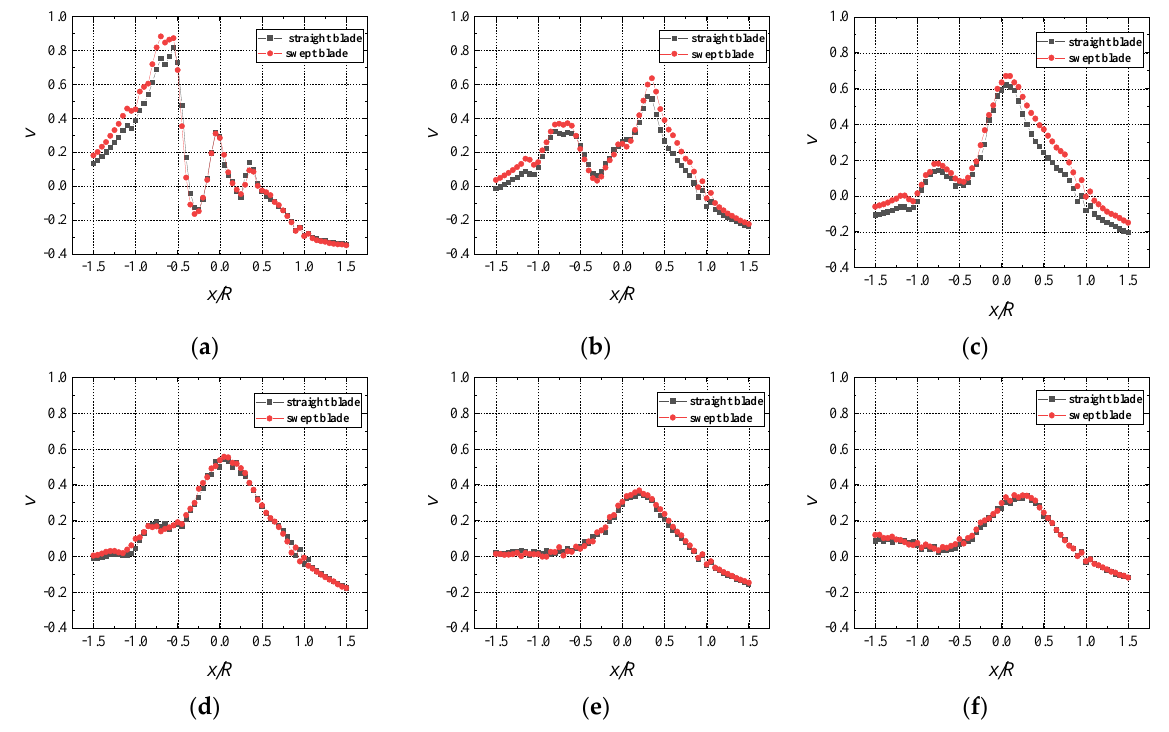
Figure 13. Lateral time-averaged velocity distribution at a yaw angle of 20° when λ = 4.1. ( a ) 0.5D; ( b ) 1D; ( c ) 2D; ( d ) 3D; ( e ) 5D; ( f ) 8D.